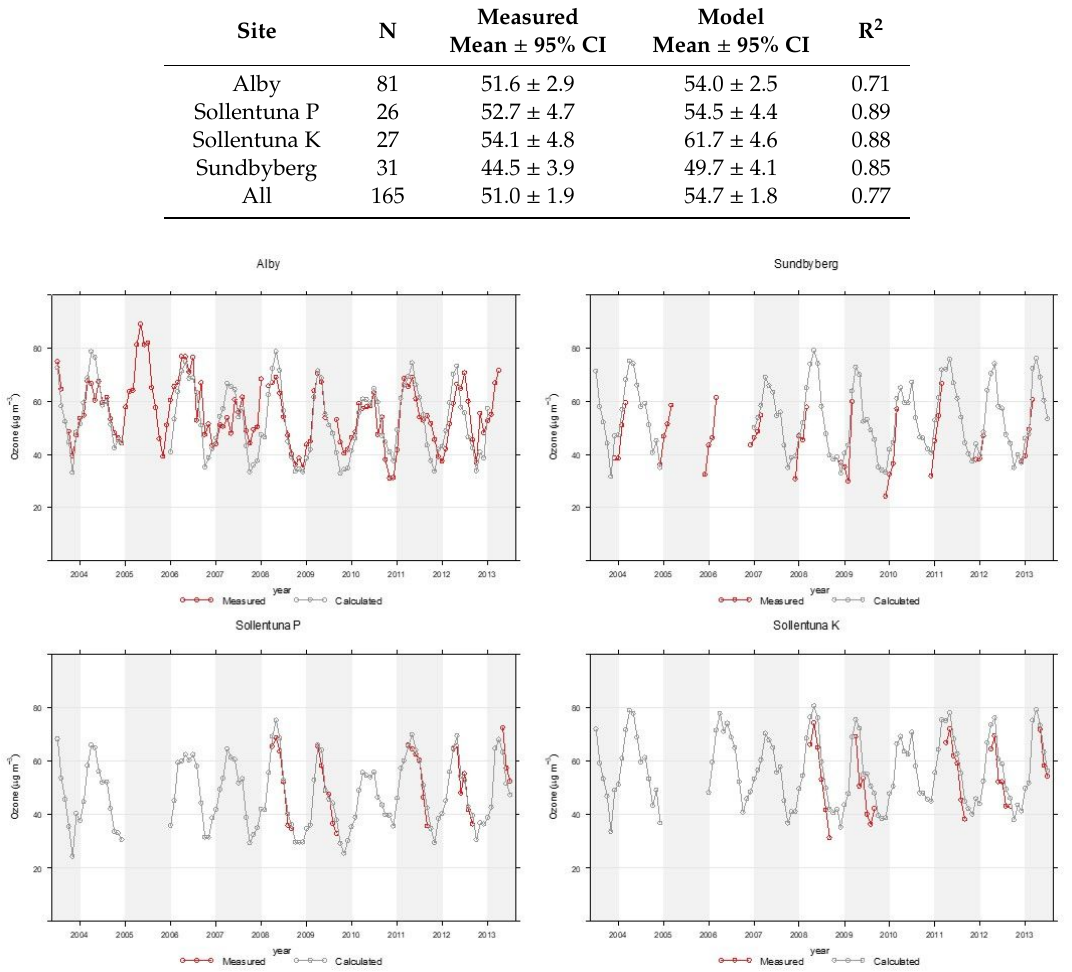
Figure A2. Mean monthly variation in measured and calculated ozone concentrations.